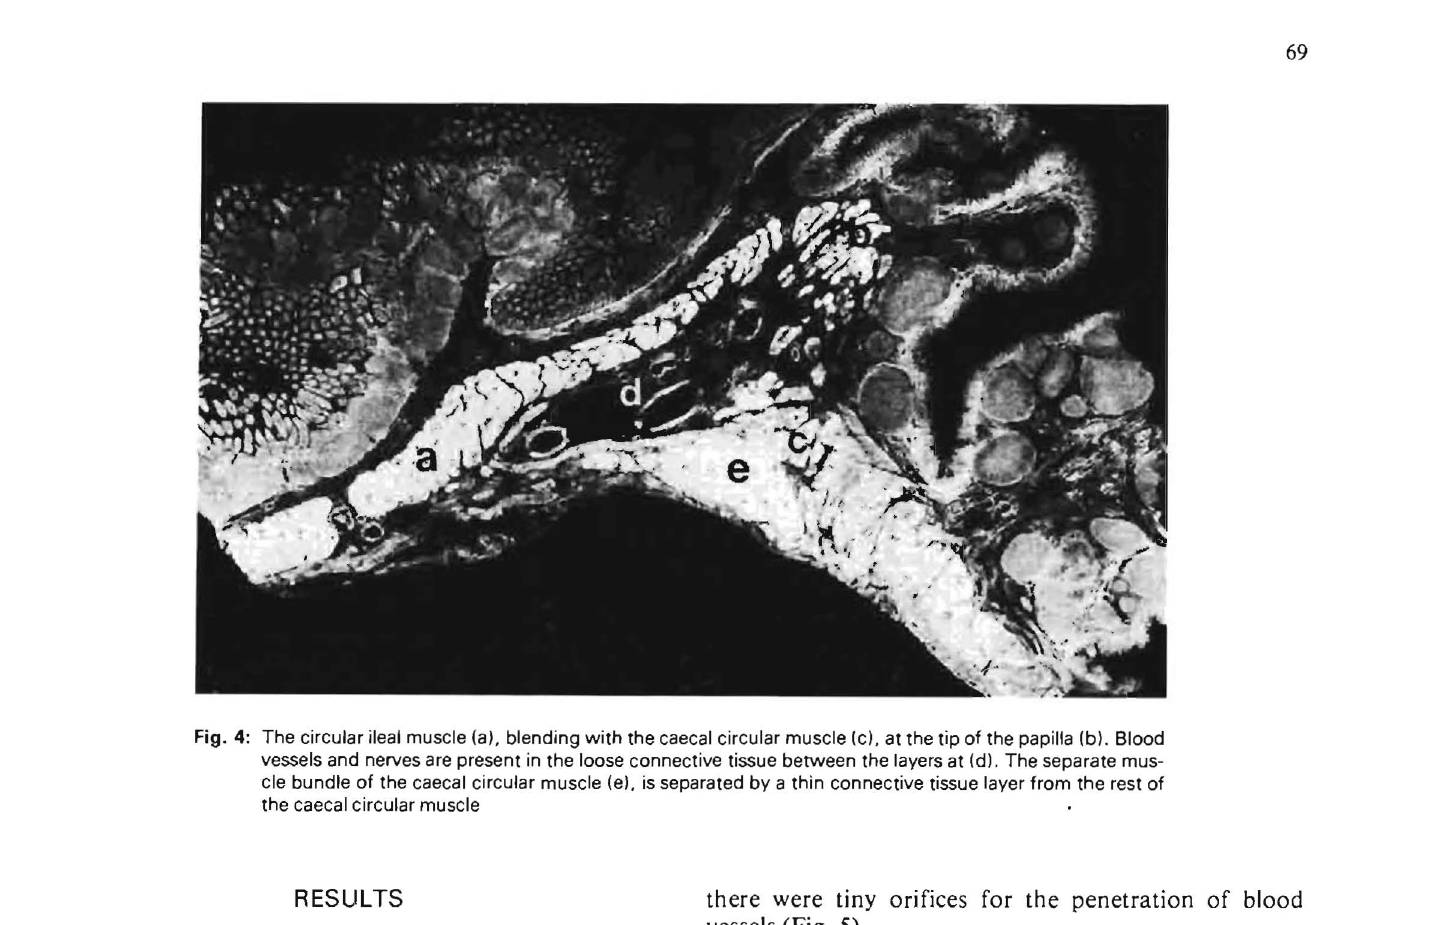
Fig. 4: The circular ileal muscle (a), blending with the caecal circular muscle (cl, at the tip of the papilla (bl. Blood vessels and nerves are present in the loose connective tissue between the layers at (dl. The separate mus cle bundle of the caecal circular muscle (el, is separated by a thin connective tissue layer from the rest of the caecal circular